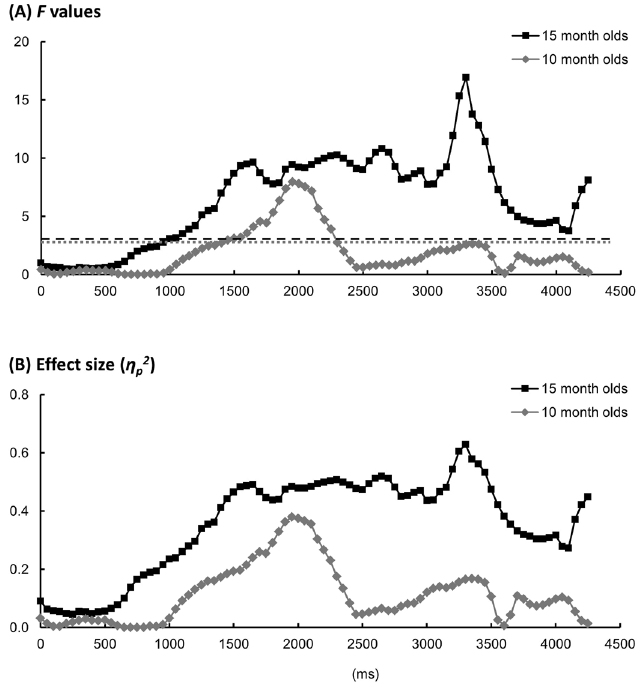
Figure 3. Results of the one-way ANOVA. ( A ) The F values in each time bin. The black dashed line represents the critical value of the F test for 15-month-olds ( F (2,20) = 3.50), and the grey dotted line represents the critical value of the F test for 10-month-olds ( F (2,26) = 3.37). ( B ) The effect size (